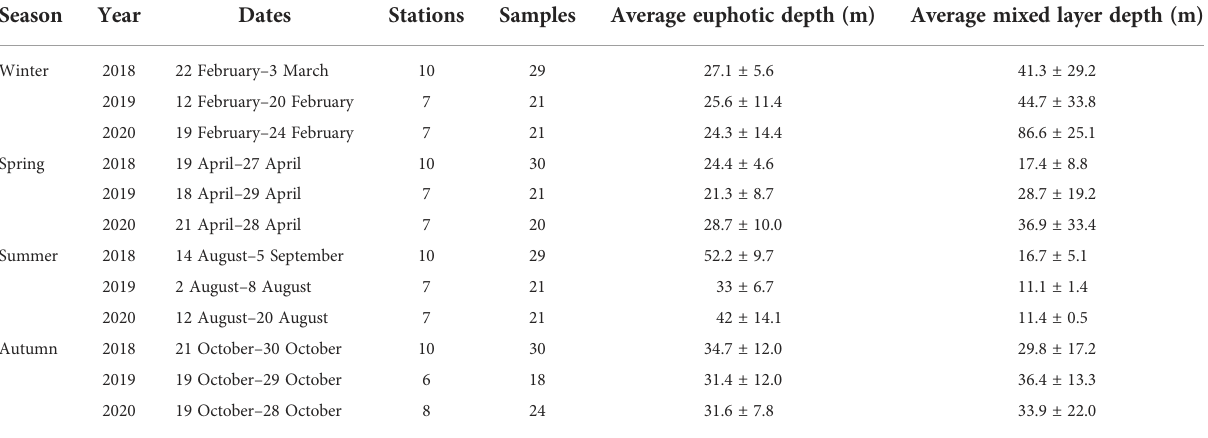
TABLE 1 Summary of samples collected during each cruise period, 2018 –